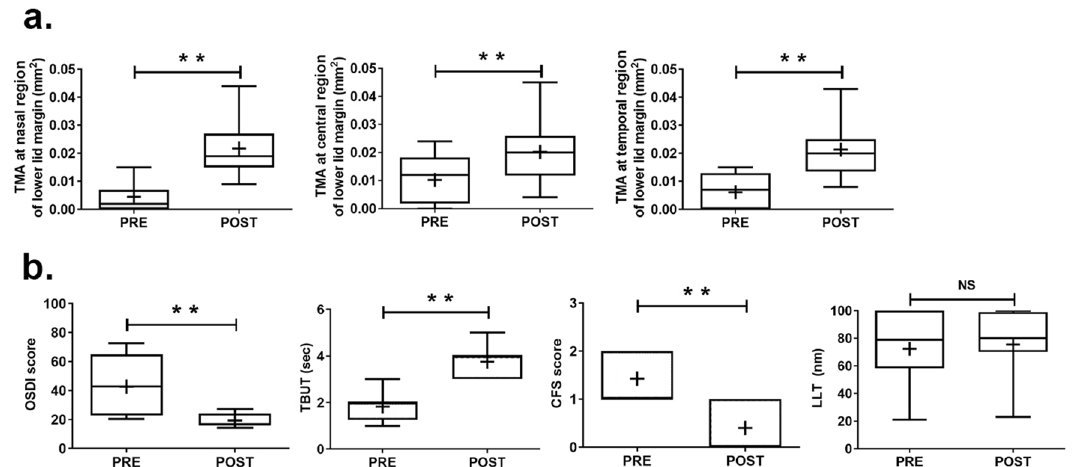
Figure 4. Changes of ocular surface parameters following high-frequency radiowave electrosurgery for conjunctivochalasis. One month after high-frequency radiowave electrosurgery was performed for conjunctivochalasis, ocular surface indexes were compared between the preoperative and postoperative conditions using the Wilcoxon signed-rank test. Among all indexes, meaningful parameters are shown with their statistical significance. ( a ) Tear film meniscus cross-sectional areas measured by anterior segment optical computed tomography (TMA). ( b ) Ocular surface disease index (OSDI), tear film break-up time (TBUT), corneoconjunctival fluorescein staining based on Oxford schema (CFS), and lipid layer thickness (LLT). (**, P < .01; NS, not